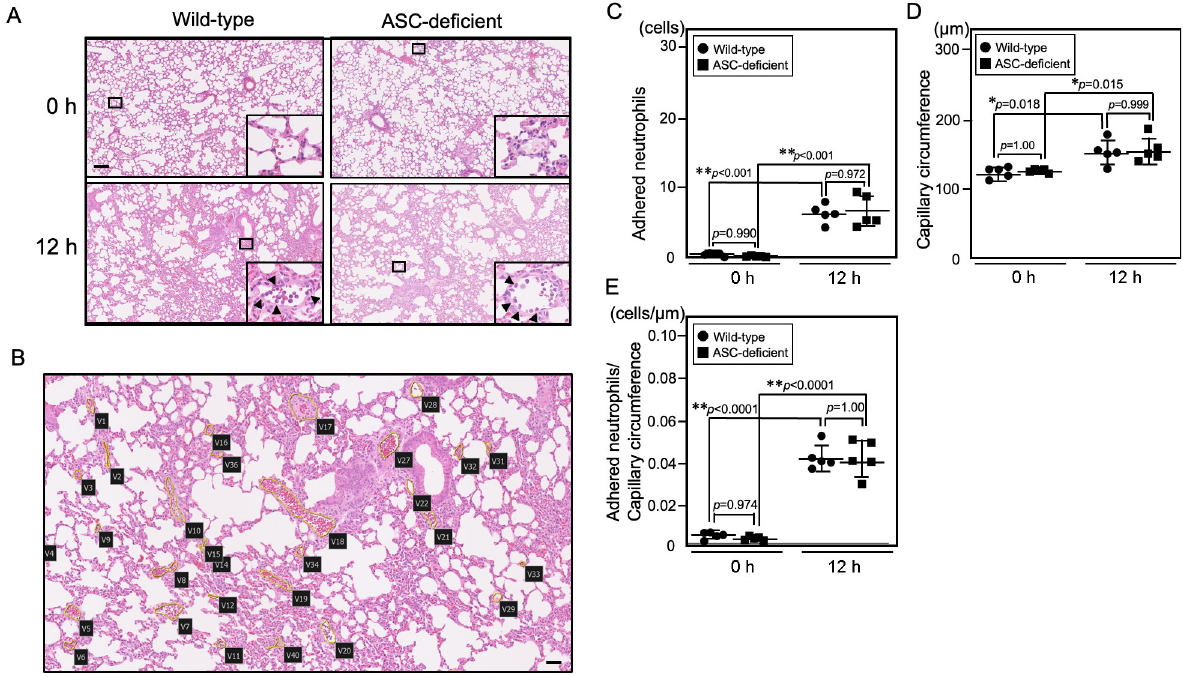
Fig 6. Histopathological comparison of acute lung damage in WT and AD mice after LPS challenge. Five mice per group were sacrificed, and each image is representative of each group. (A) HE staining of the lung before (0 h) and at 12 h after LPS challenge. Neutrophils adhering to endothelium are indicated by arrowheads. Bar = 100 μ m. (B) Illustration of the method used to measure the number of neutrophils adhering to the endothelium of interstitial capillaries, and the mean capillary circumference. The total number of neutrophils in the capillaries marked by a yellow line was counted. In total, 34 capillaries were counted, and the circumference of each was measured. The number of neutrophils per unit of capillary circumference was calculated. Bar = 100 μ m. (C) The mean number of neutrophils adhering to endothelium of interstitial capillaries. (D) The mean capillary circumference. (E) Number of neutrophils adhering to the endothelium of interstitial capillaries versus the circumference of the dilated capillaries. Results are expressed as the mean ± standard deviation. � p -value < 0.05. �� p -value < 0.01.